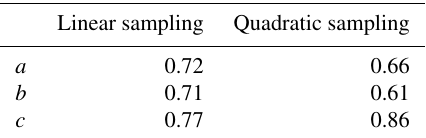
Table 1. Fitted parameters for Eq. (11) obtained from the data of Fig. 2. No error estimates are given as the data fitted are not nor- mally